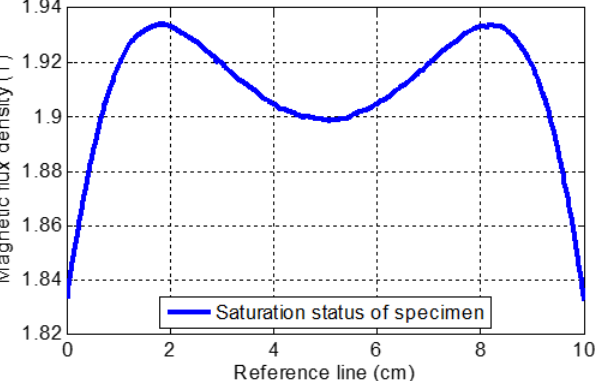
Figure 6. Specimen’s magnetization level for both conventional and proposed numerical simulation.